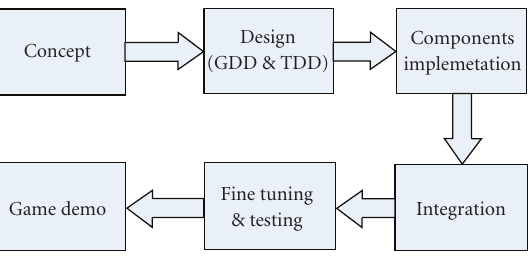
Figure 1: Game design process.